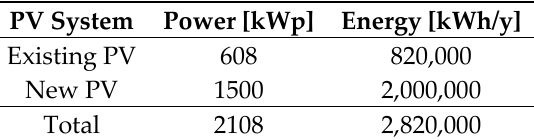
Table 3. Berchidda’s PV